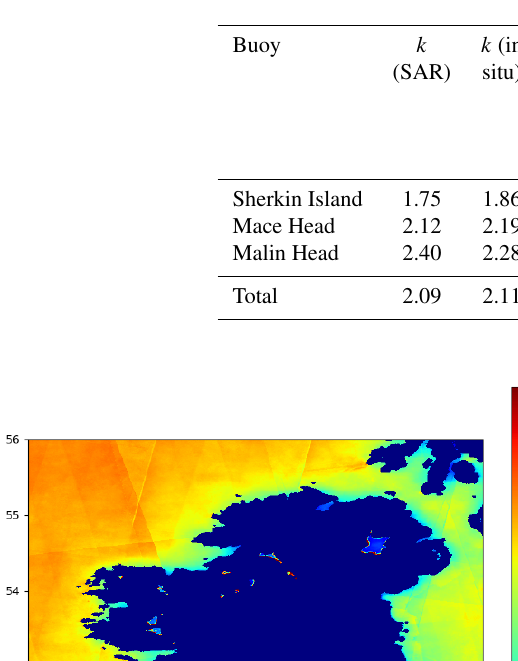
Table 7. Comparison of wind speed long-term statistics obtained from the three coastal weather stations with the ones obtained from the SAR data. These values are the results of the match-up comparison exercise and are used to evaluate the accuracy of the satellite data.